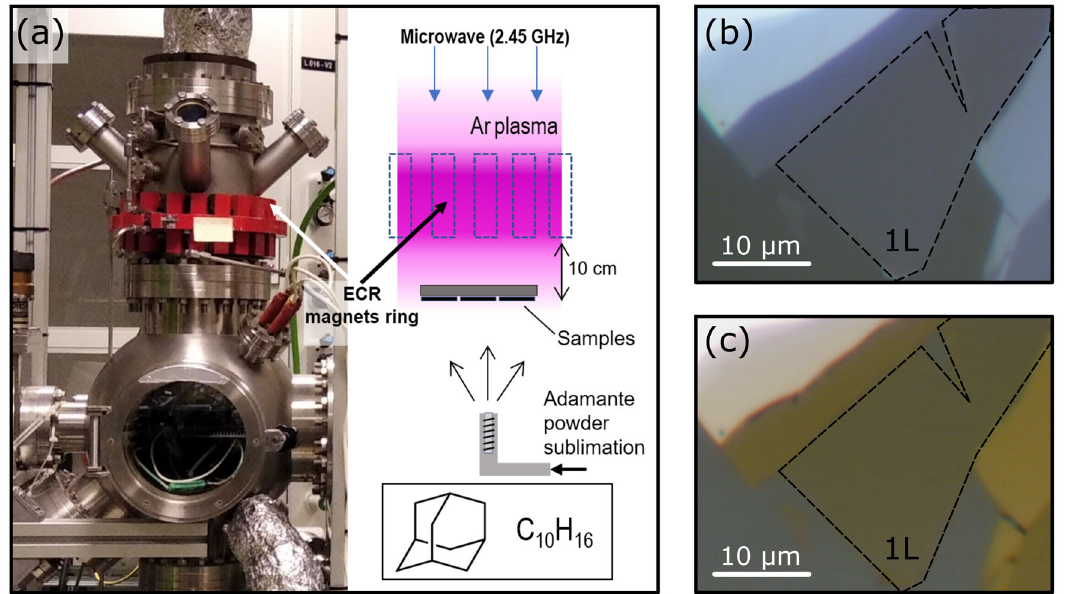
Fig. 1 Fabrication of adamantane encapsulated MoS 2 samples. a Experimental setup for the synthesis of adamantane plasma polymers by remote plasma-assisted vacuum deposition (RPAVD). The chemical structure and formula of adamantane are included in the top right part of panel a . b Optical image of 1L-MoS 2 on a polycarbonate substrate. c Same sample after encapsulating it with 50 nm of adamantane plasma